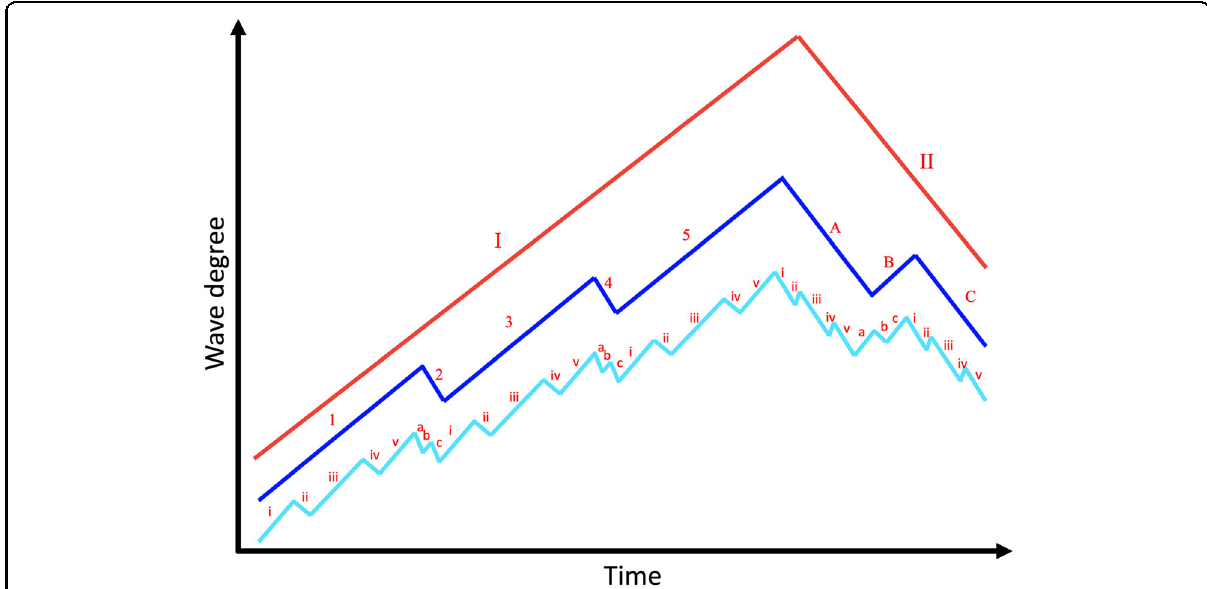
Fig. 1 Elliott waves of smallest degree or dimension (sub-waves; cyan) are shown along with the waves of higher degree (waves, blue; super-waves, red). i, iii, v are impulses of the smallest dimension; 1, 3, 5 are impulses of next higher dimension; I is the impulse of next higher dimension. Similarly, ii and iv are correctives of the smallest dimension, 2 and 4 are correctives of the next higher dimension, and II is the corrective of next higher dimension. Impulses (e.g., I) are made up of 5 waves of lesser dimension (i.e., 1, 2, 3, 4, 5), while correctives (e.g., II) are made up of 3 waves of lesser dimension (i.e., A, B,